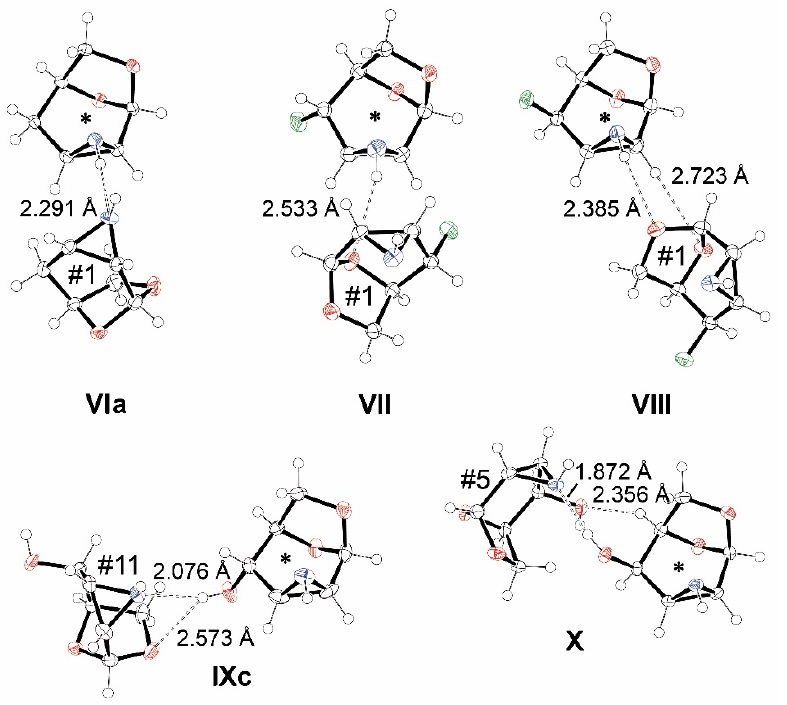
Figure 5. ORTEP presentation of the strongest intermolecular interactions found in the structures of endo ‐ epimines VI – X . * denotes a parent molecule. endo -epimines VI – X . * denotes a parent